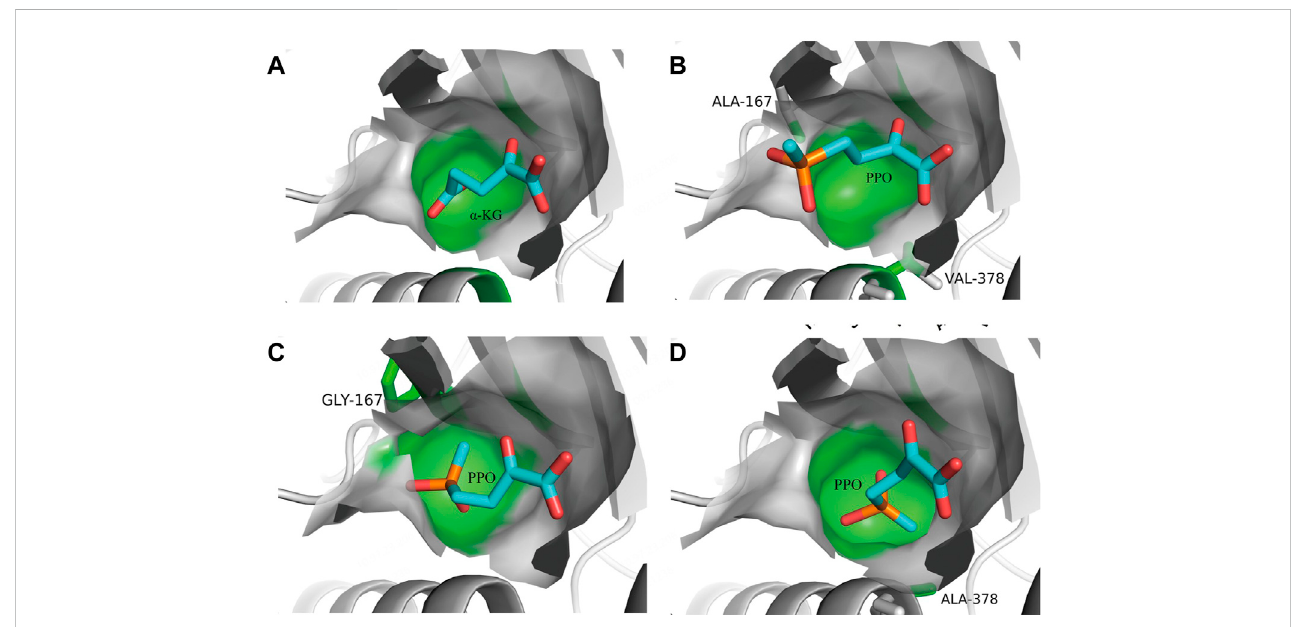
FIGURE 2 Rational design of glutamate dehydrogenase based on steric hindrance. (A) , Pp GluDH docked with native substrate α -KG. (B) , Pp GluDH docked with non-natural substrate PPO. (C) , Pp GluDH variant A167G docked with non-natural substrate PPO. (D) , Pp GluDH variant V378A docked with non-natural substrate PPO. Reprinted with permission from (Yin et al., 2019). Copyright 2019 Wiley-VCH Verlag GmbH & Co. KGaA,